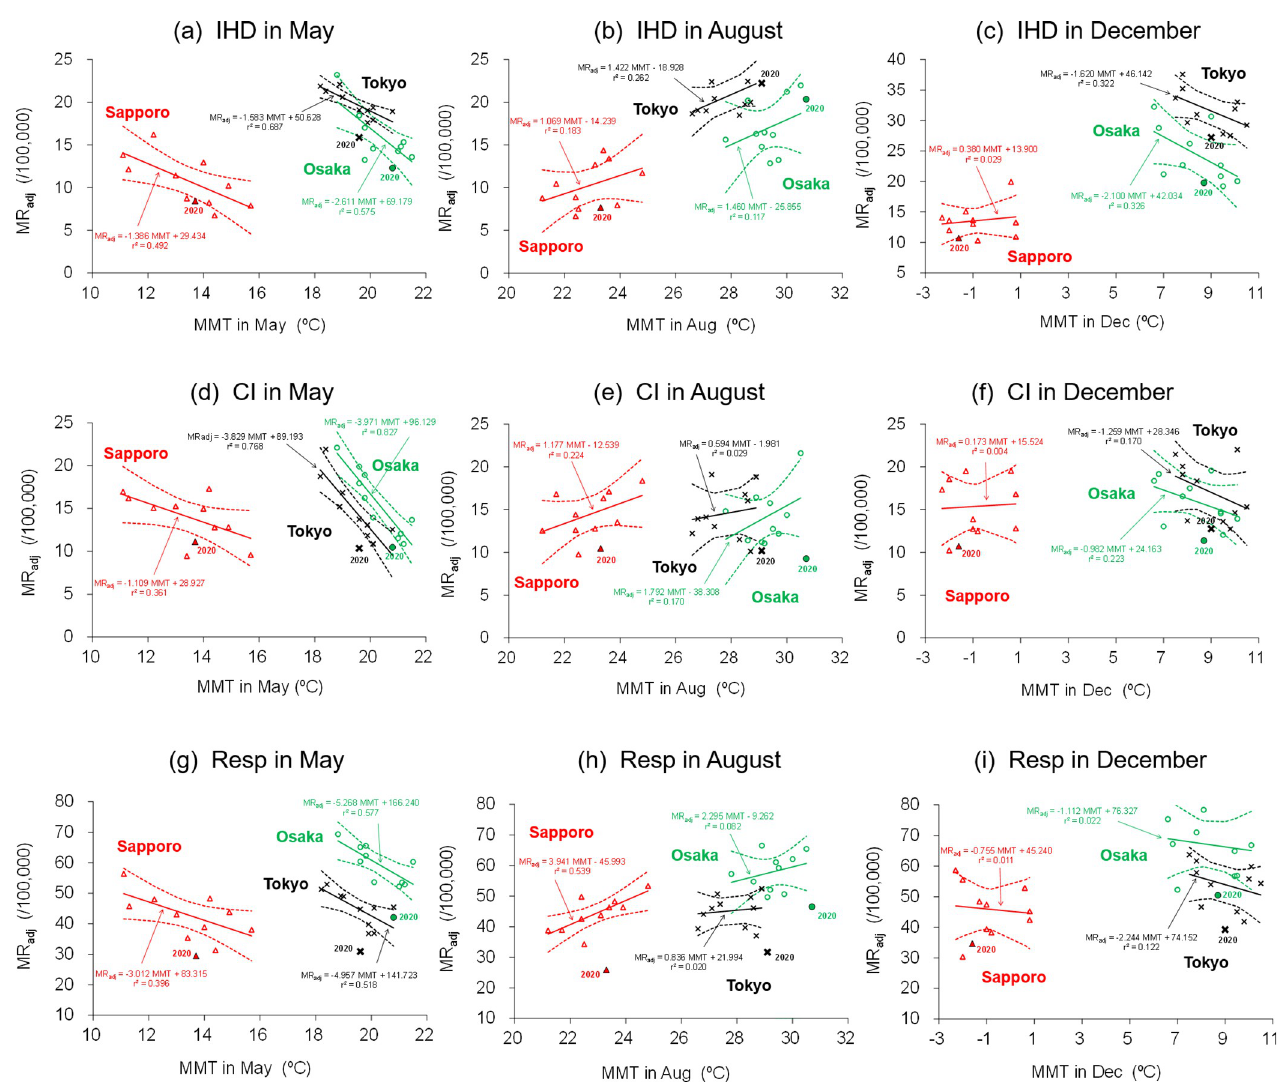
Fig 4. The MR adj sensitivity to MMT analysed from the past data and the 2020 plots in Sapporo (red triangle), Tokyo (black cross), and Osaka (green circle). The results of (a, b, c) acute ischemic heart disease (IHD), (d, e, f) cerebral infarction (CI), and (g, h, i) respiratory diseases (Resp) are exhibited for May, August, and December. Straight regression line and the 95% confidence interval (broken curve line) are presented for the pre-pandemic period (2010–2019), while filled marks represent the results of the COVID-19 pandemic year (2020). Regression equations and their contribution rates are also shown for the regression